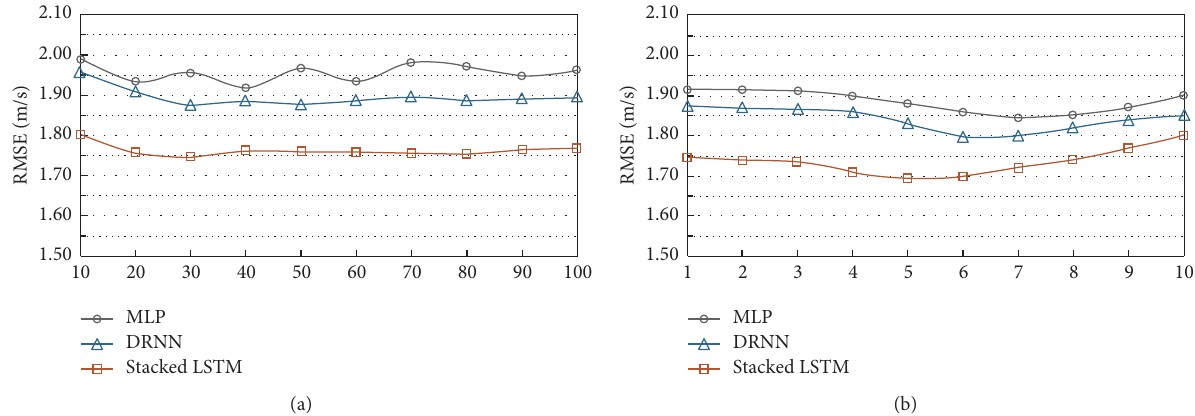
Figure 8: Sensitivity of model parameters on the Yilan gauge: (a) number of neurons in a middle layer and (b) length of middle